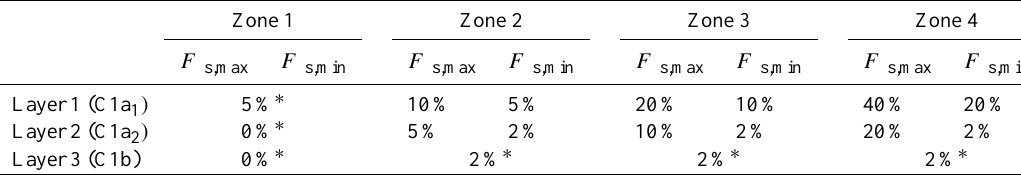
Table 1. Maximum and minimum fissure fraction as defined per zone and per layer. Zone 1 Zone 2 Zone 3 Zone 4 F fis,max F